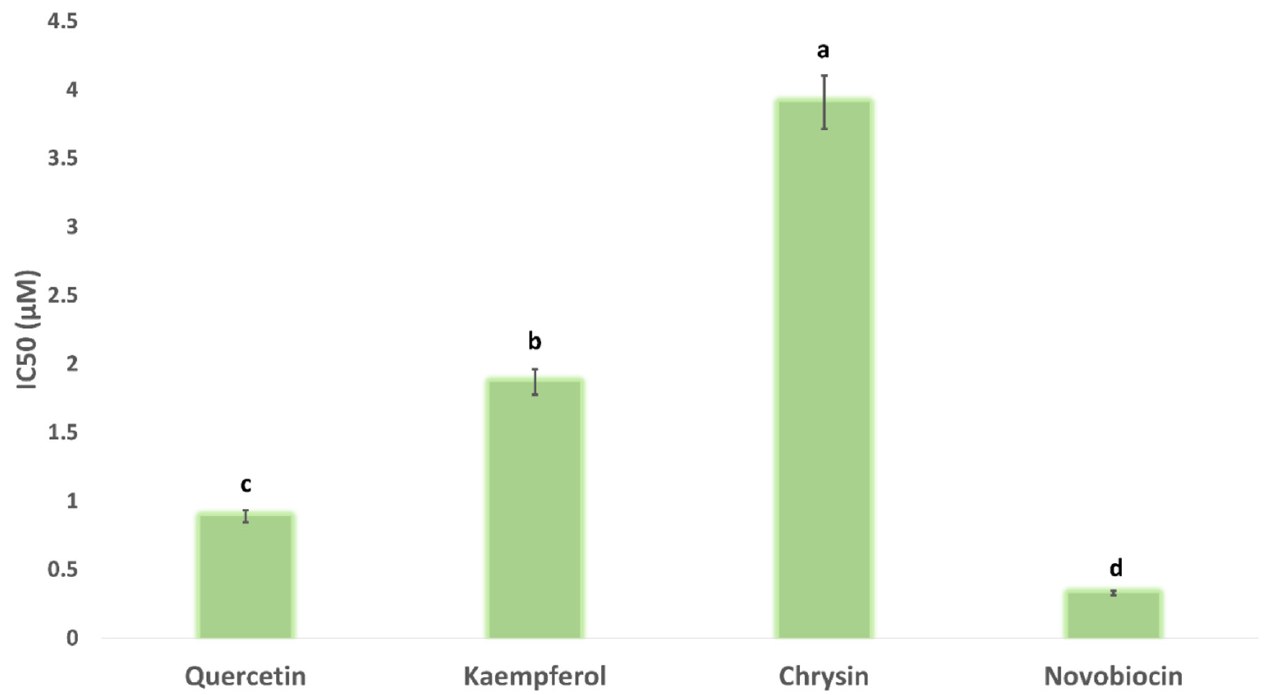
Figure 6. Gyr-B inhibitory activity of quercetin, kaempferol, and chrysin expressed as IC 50 . Bars represent standard errors. Different letters indicate significant differences from repeated-experiments ( n = 3) ANOVA (Hotelling’s T 2 , p < 0.05).